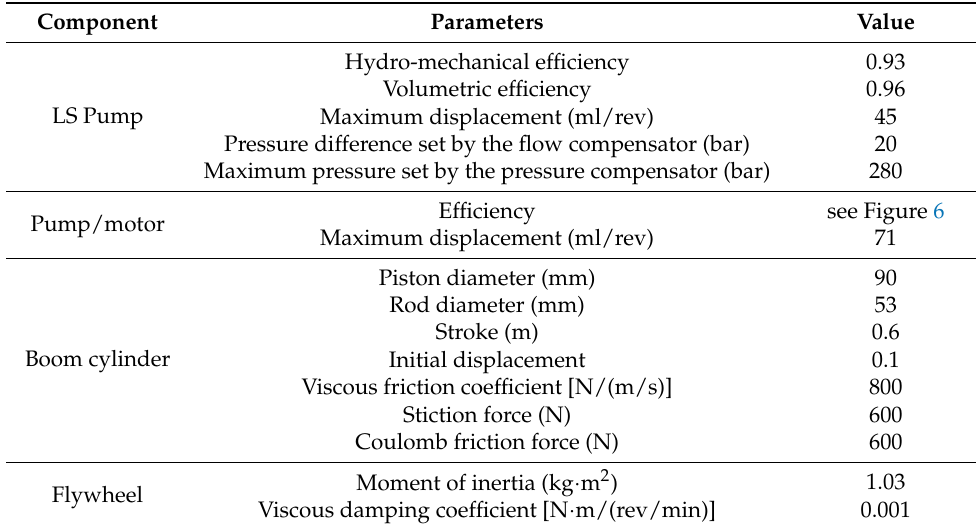
Figure 5. The simulation model established in AMESim. Table 1. The pertinent parameters of the simulation model [23].